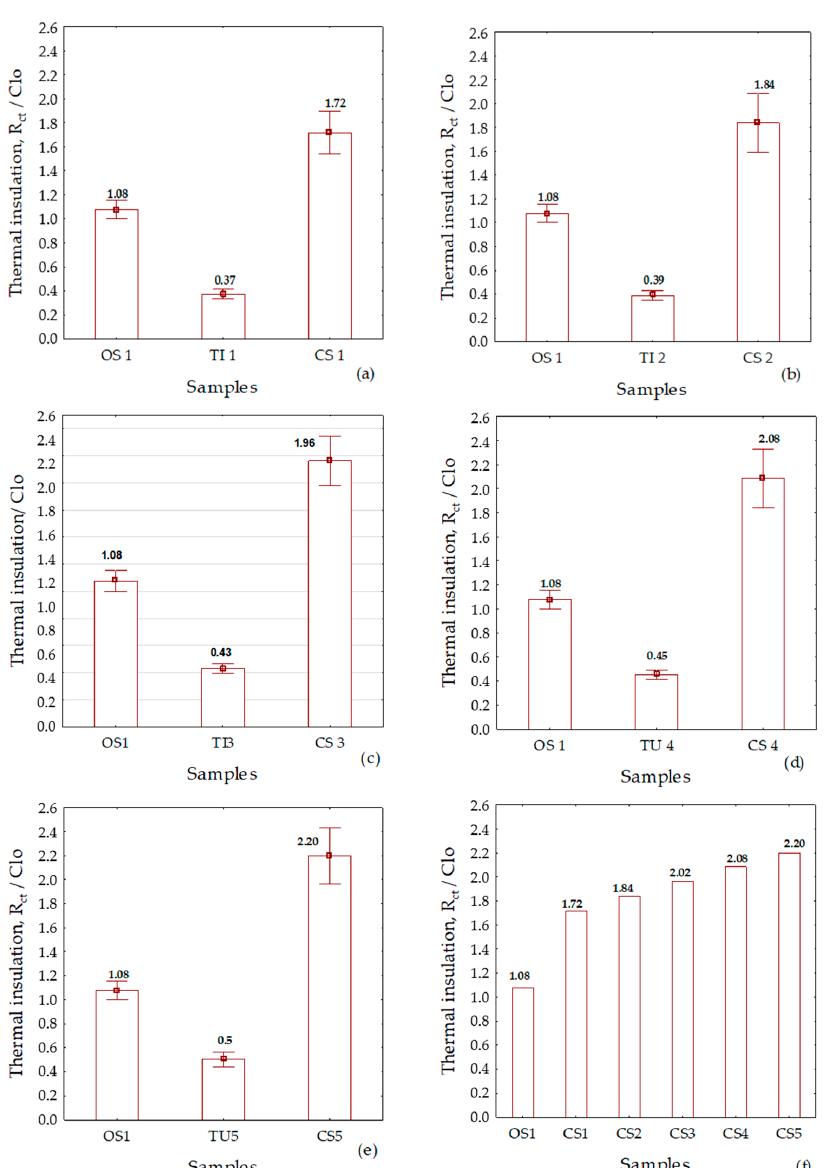
Figure 4. Graphical representations of the measurement results of the thermal insulation of the outer shell, thermal inserts, and clothing systems: ( a ) Clothing system (CS1); ( b ) clothing system (CS2); ( c ) clothing system (CS3); ( d ) clothing system (CS4); ( e ) clothing system (CS5); ( f ) increasing the thermal insulation of the clothing systems by installing thermal inserts of di ff erent masses per unit